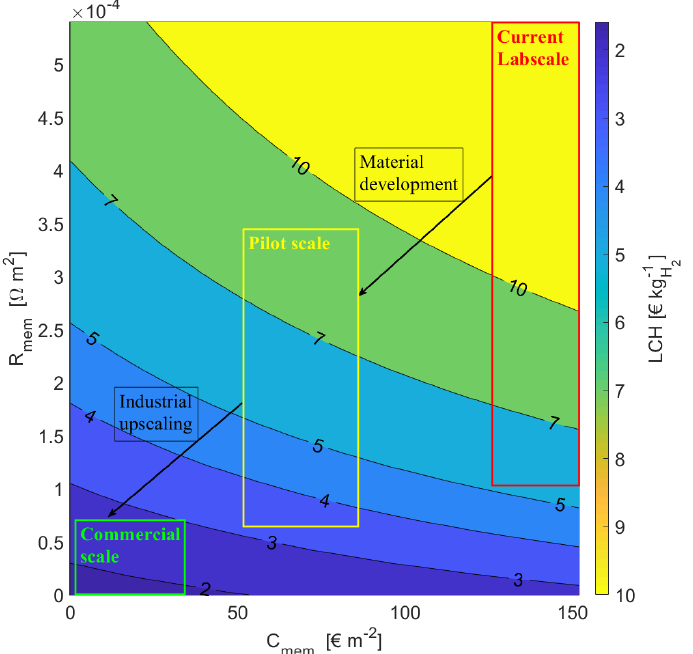
Figure 10. Levelised cost of hydrogen (LCH) as a function of membrane resistance for different mem- brane cost. Here, we assume the membrane resistances R aem = R cem . CSO and FAS30 permselectivities were measured and used as input. The membrane cost range assumed for lab, pilot and commercial scale is 130–150, 50–80 and less than 30 € m − 2 , respectively. The cost of heating is assumed to be 0.005 € kWh − 1 [26]. We assume for the pilot scale, that the material development will lead to cheaper and less resistive membranes, i.e., SPEEK or carbon-based membranes, and that for the commercial scale these membranes will be produced at large scale (60 × 10 8 m 2 per year) and reduced thickness (25 µ m and maintaining the mechanical strength) which will in turn reduce the cost and resistance further